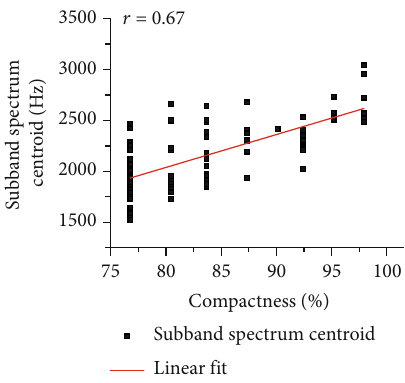
Figure 10: Correlation graphs of soil samples with di ff erent compaction degrees under the action of 45(L) N hammering force and the centroid of sound subband spectrum.